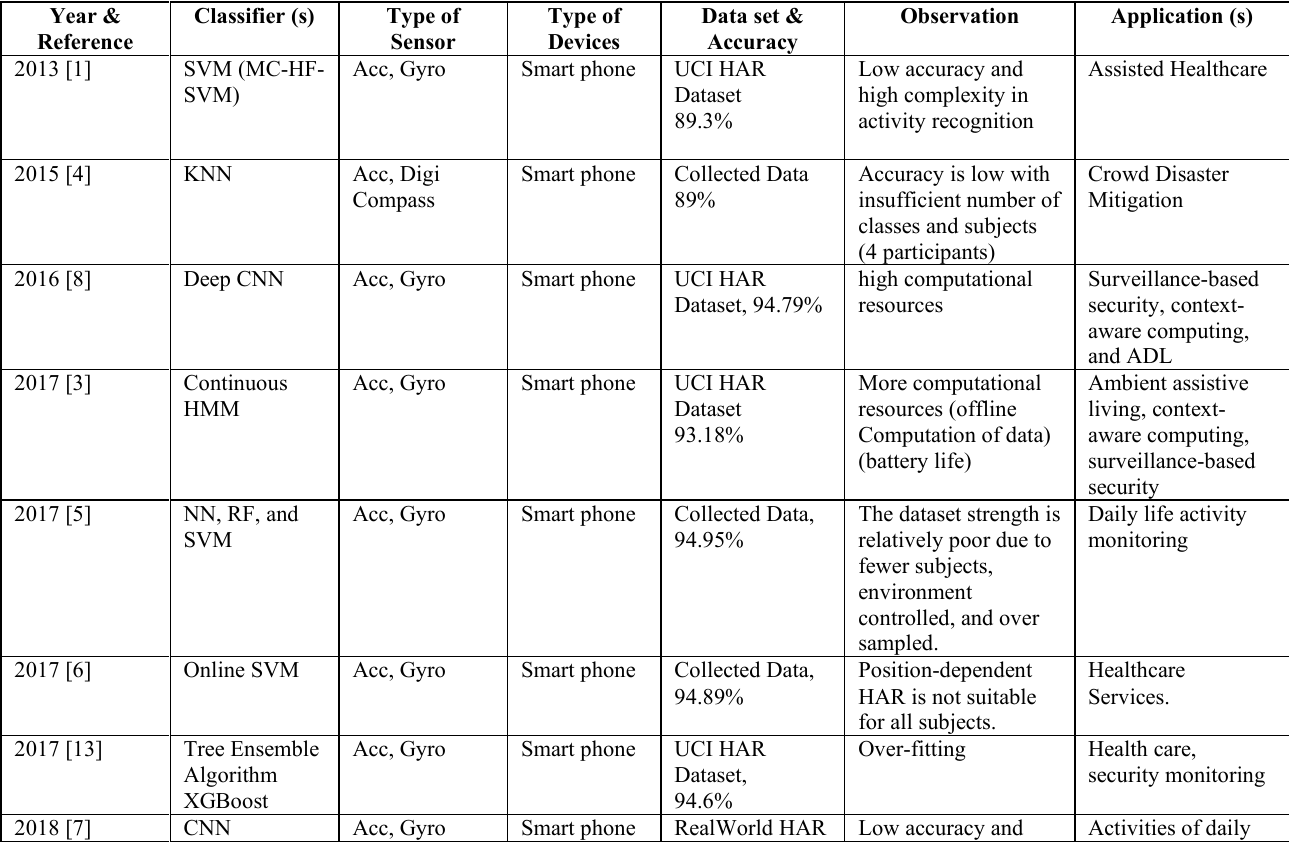
Table 1. Existing literature on activity